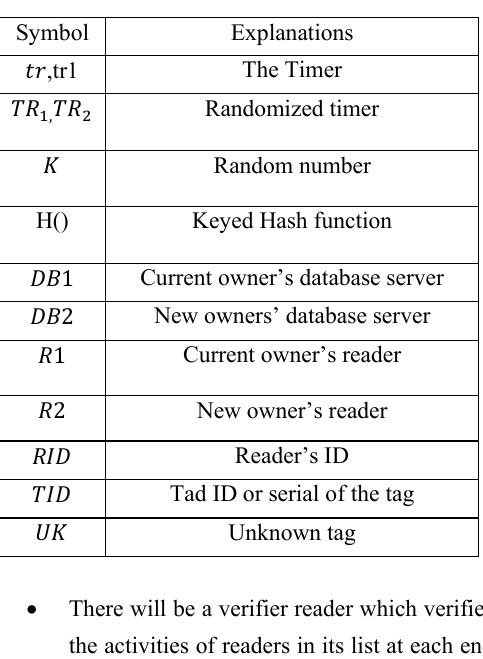
Table 1: Symbols and their descriptions